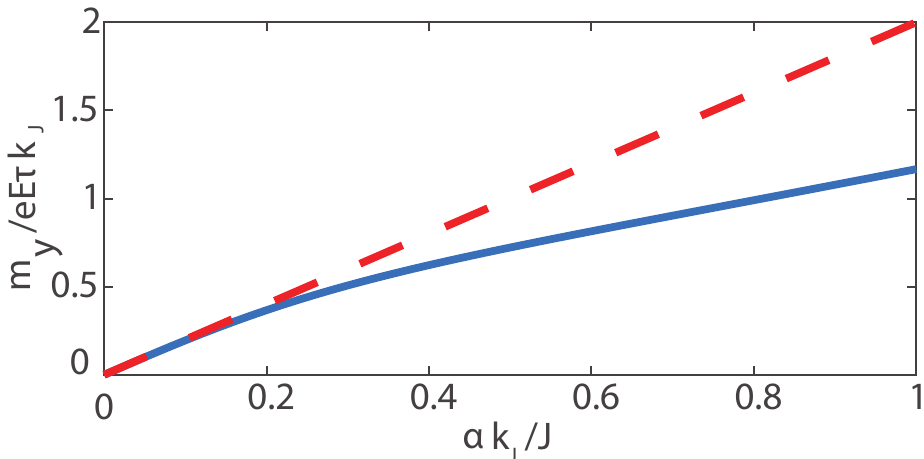
Figure 4. Spin accumulation along the y axis m y vs. Rashba SOC constant α , where the solid line is the result based on the split bands and the dashed line is based on the band of ferromagnetic electron